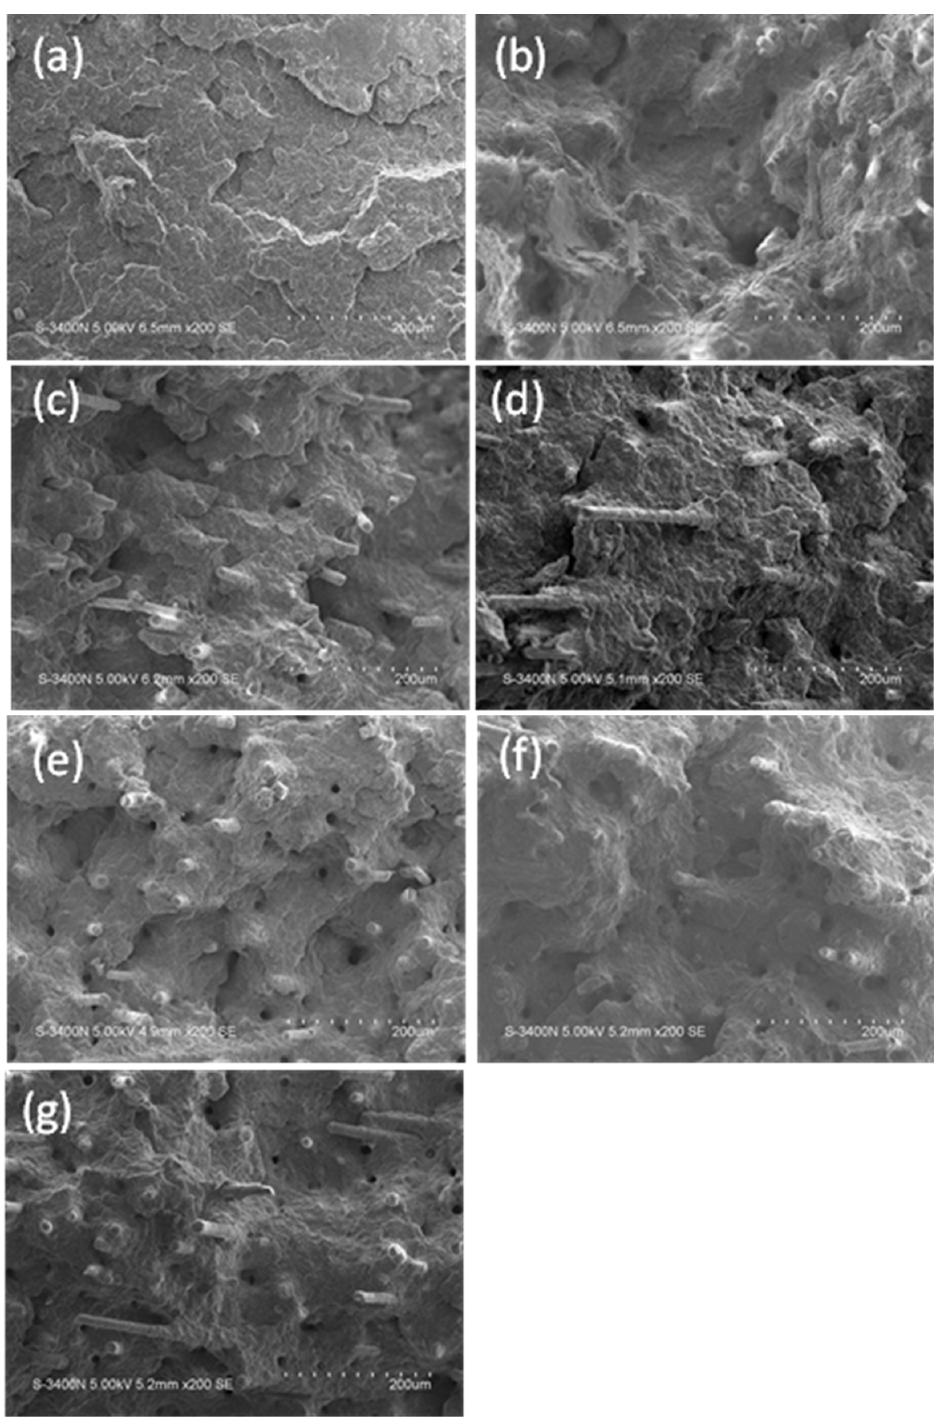
Figure 10. SEM images of PP, GFRP and β -GFRP. ( a ) Pure PP; ( b ) GFRP; ( c ) β -GFRP-5; ( d ) β -GFRP-10; ( e ) β -GFRP-15; ( f ) β -GFRP-20; ( g ) β -GFRP-25.